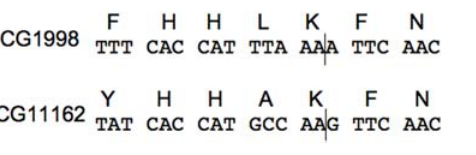
Figure 3. Segments of the Drosophila paralogs CG1998 and CG11162 (homologs of Erg25) and the corresponding concep- tual translations. The interruption of the open reading frames of both genes, by their last intron, is shown by vertical lines.